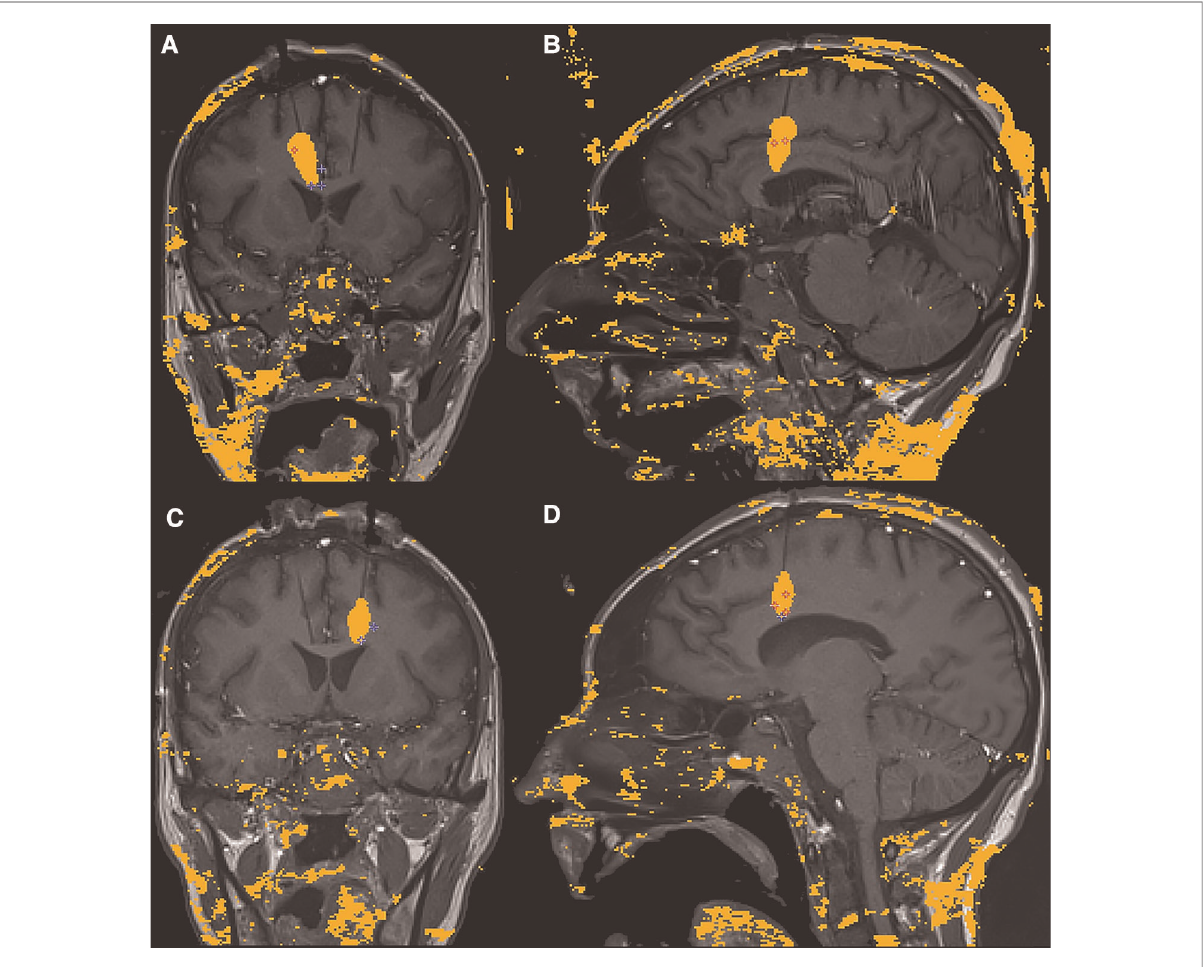
FIGURE 3 Intraoperative sagittal and coronal MRI thermometry images of the completed right ( A,B ) and left ( C,D ) anterior cingulotomy laser-induced thermal